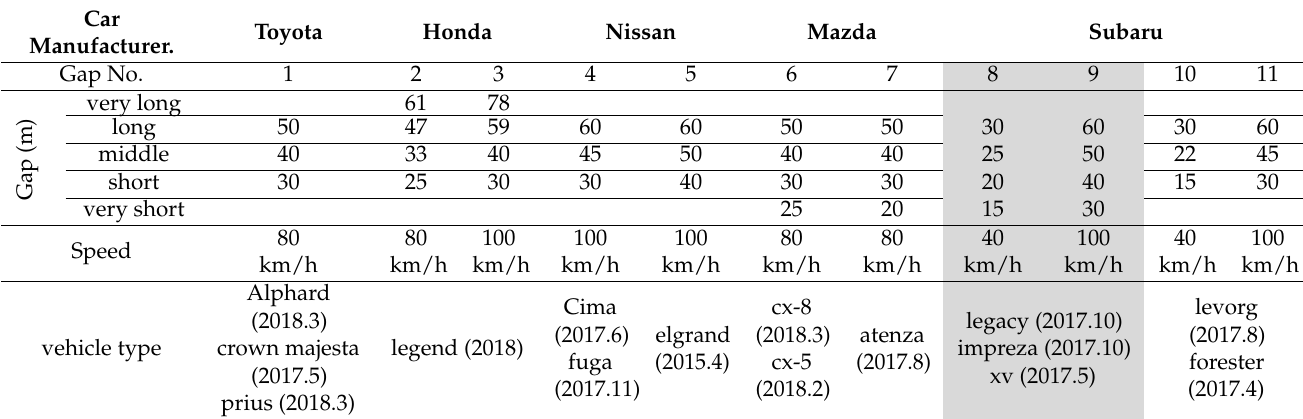
Table 2. Desired gap of FACC